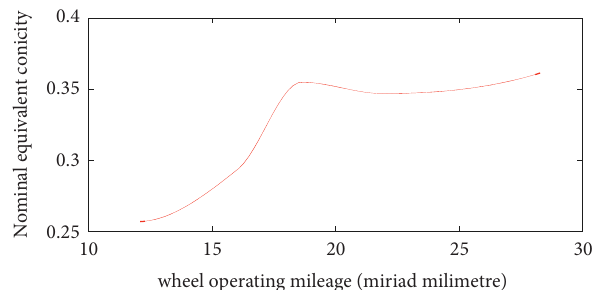
Figure 10: Nominal equivalent conicity under different wheel wear